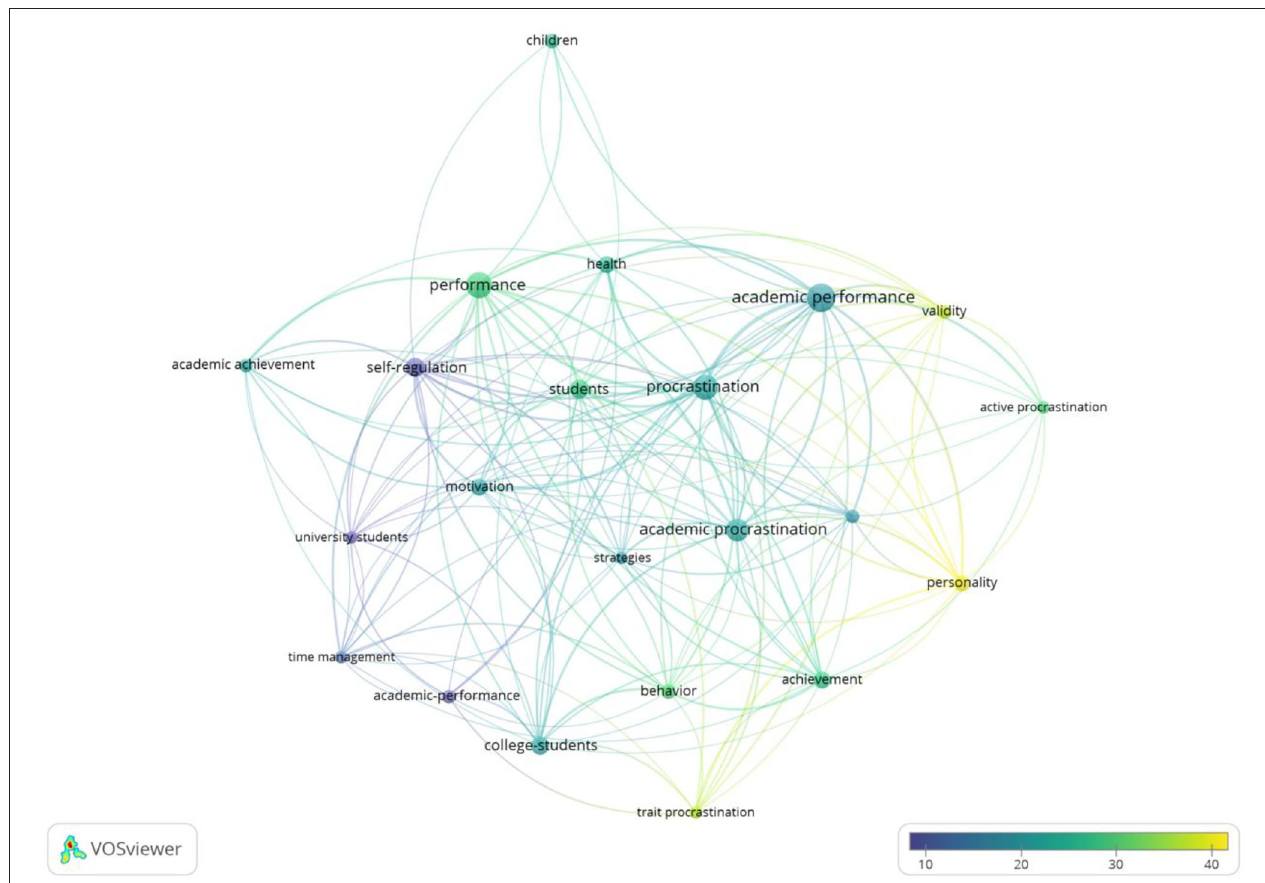
FIGURE 10 | Overlay visualization based on academic performance link-weights and citation